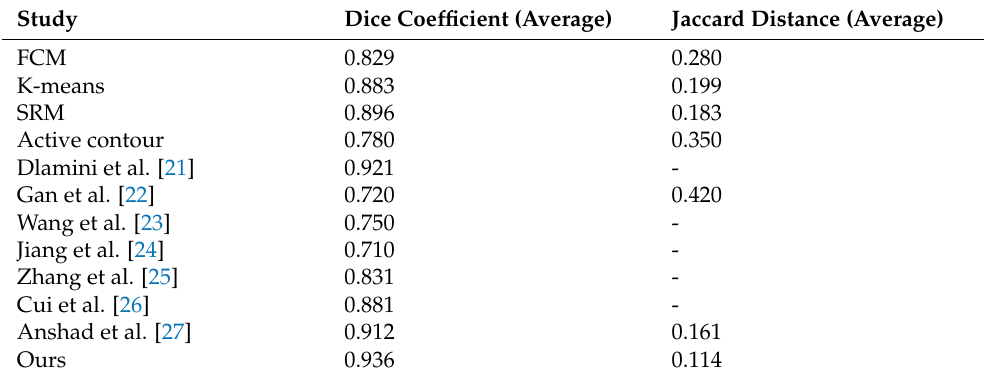
Table 3. Comparison of the segmentation performance of our proposed method with previous studies in the same problem